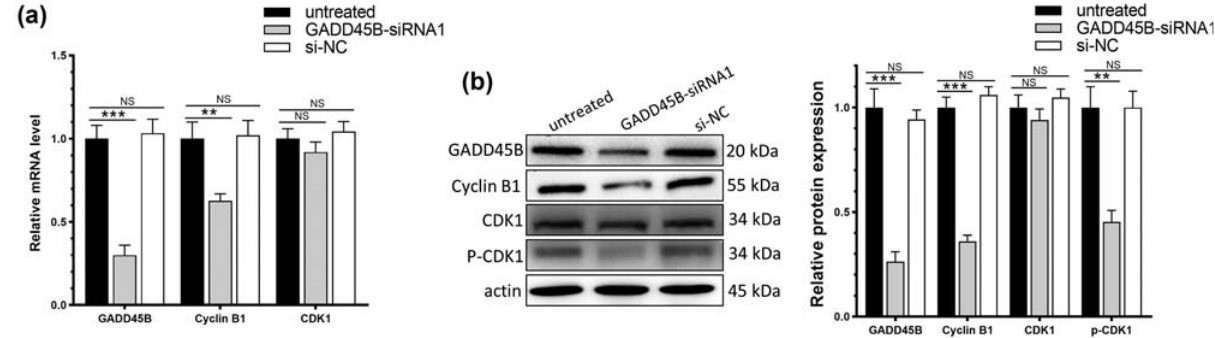
Figure 6: Regulation of gene expression by knockdown of GADD45B and radiation treatment: ( a ) RT - qPCR of downstream pathway genes and ( b ) western blot analysis of downstream pathway